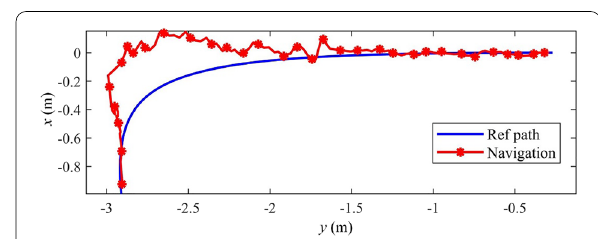
Figure 17 Four transmission distances of ultrasonic signals